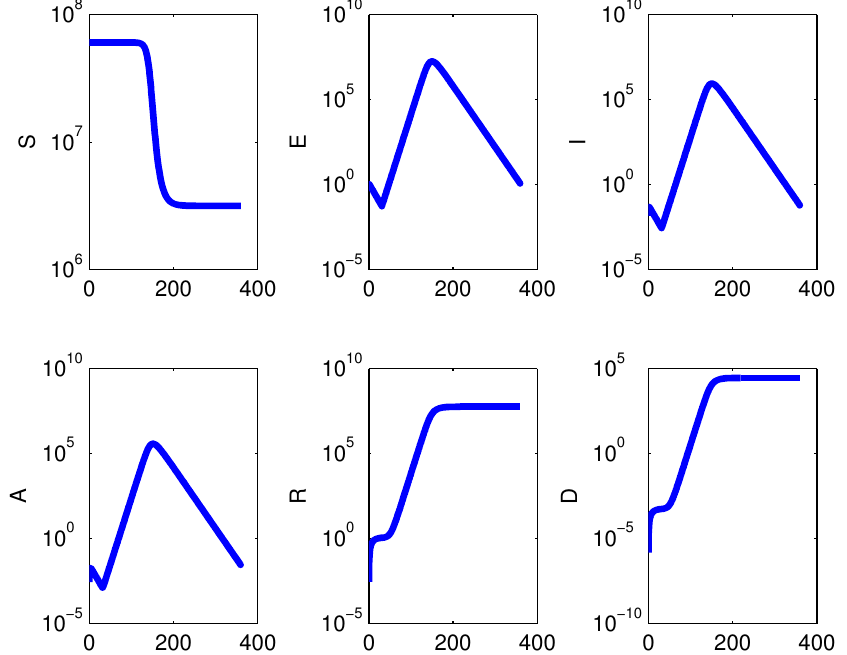
Figure 8. Using a semilogarithmic scale for the vertical axis, we show the results of starting the restrictions at time t 1 = 1, setting β I = 10 − 10 and lifting them at time t 2 = 30, returning to β I = 10 − 7 one month later, over a one year timespan for the simplified model with no demographics (1) where we take Λ = 0, d p = 0. Left to right and top to bottom, the subpopulations are: S , E , I , A , R and D , the disease-related deceased